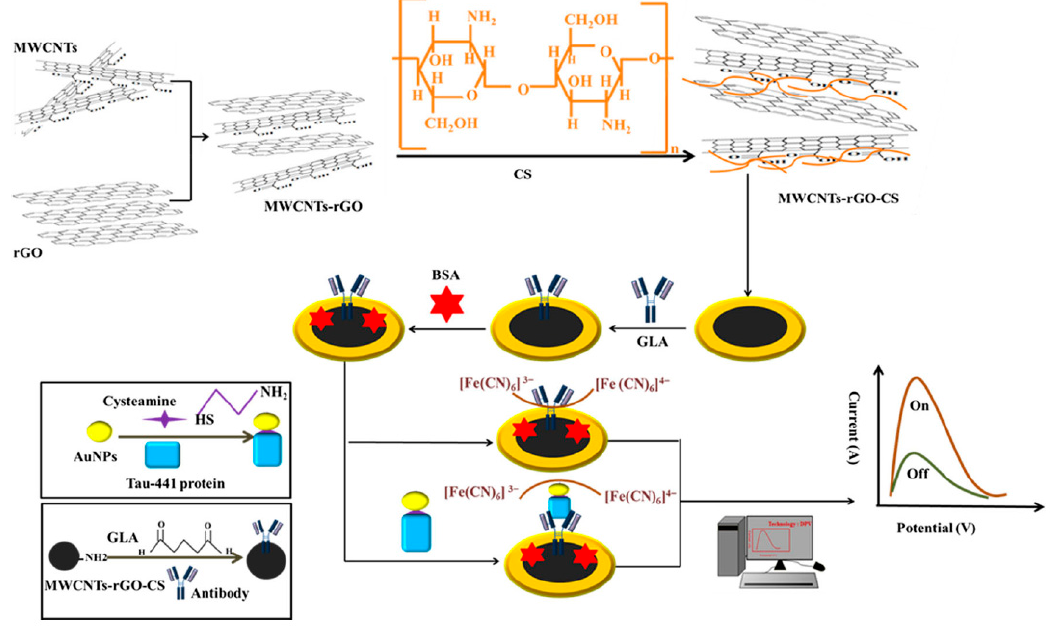
Figure 9. A “signal off” ECB for the voltammetric detection of Tau-441 protein. Assembly of multi-walled carbon nanotubes-reduced graphene oxide-chitosan-antibody (MWCNT–rGO–CS) over the gold electrode for the voltammetric detection of AuNP–Tau-441 conjugate [112]. Reprinted with permission from [112], Copyright © 2020, Springer Nature.